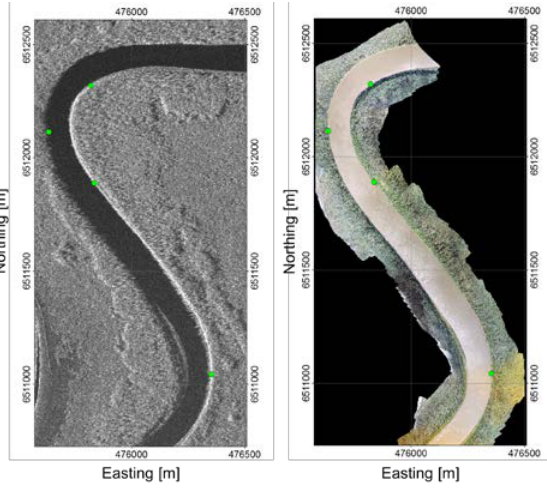
Figure 9. The test area shown in the RADARSAT-2 image (left) and sUAS ortho-image mosaic (right). The green dots represent the GPS ground control points used to further correct the planimetry of the sUAS ortho-image mosaic.